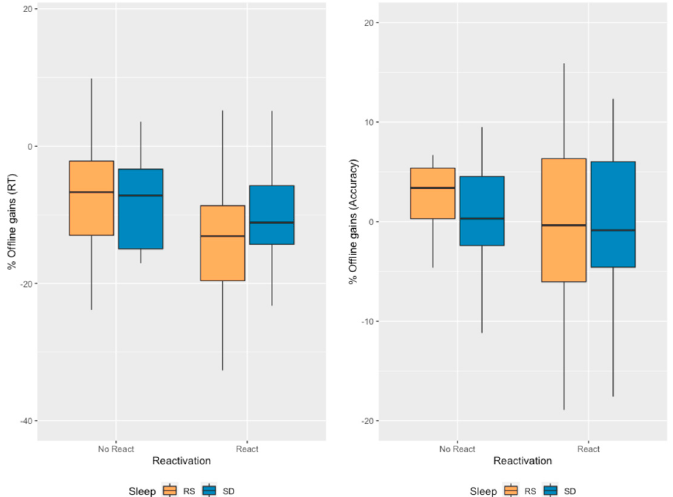
Figure 4. Offline gains in performance. The offline gains were computed by subtracting the mean of blocks 23 and 24 (T3) to the mean of the two last blocks of the LS (thus, blocks 19 and 20—T1) divided by the mean of the two last blocks of the LS before multiplying the score by 100 to obtain a percentage. No significant Reactivation, Sleep or interaction effects are evidenced.